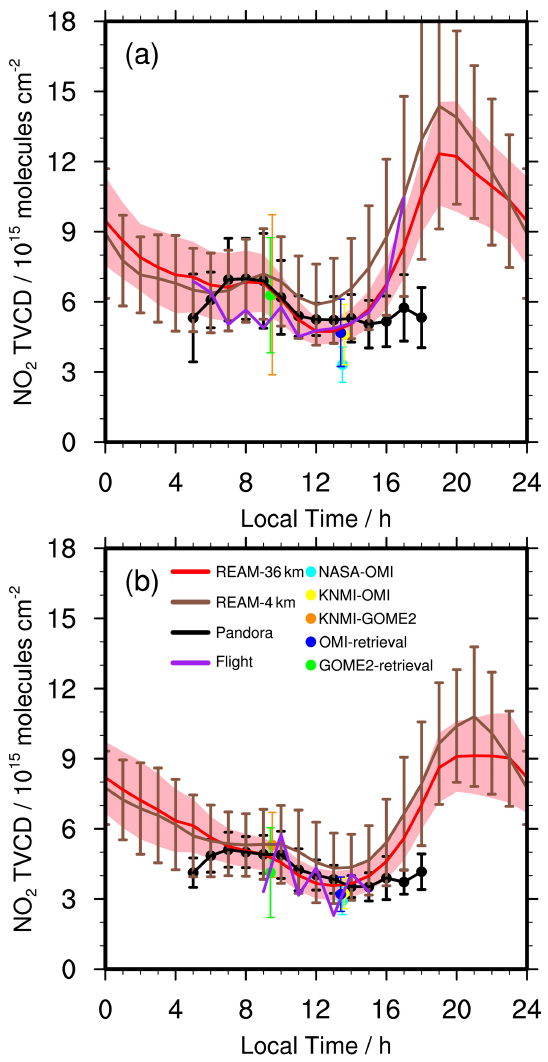
Figure 10. Daily variations in NO 2 TVCDs on (a) weekdays and (b) weekends during the DISCOVER-AQ campaign. “REAM- 36km” refers to the 36km REAM simulation results over the 11 inland Pandora sites. “REAM-4km” refers to the 4km REAM simulation results over the 11 inland Pandora sites. “Pandora” refers to updated Pandora TVCD data. “Flight” denotes P-3B- aircraft-derived NO 2 VCDs below 3.63km. “NASA-OMI” de- notes the OMI NO 2 TVCDs retrieved by NASA over the Pandora sites; “KNMI-OMI” denotes the OMI NO 2 TVCDs from KNMI; “KNMI-GOME2” is the GOME-2A NO 2 TVCDs from KNMI. “OMI-retrieval” and “GOME2-retrieval” denote OMI and GOME- 2A TVCDs retrieved by using the KNMI DOMINO algorithm with corresponding 36km REAM vertical profiles, respectively. The ver- tical bars denote corresponding standard deviations for all data ex- cept the 36km REAM simulation results, the standard deviations of which are shown with pink shading. We list NO 2 TVCD values at 09:30 and 13:30LT in Table